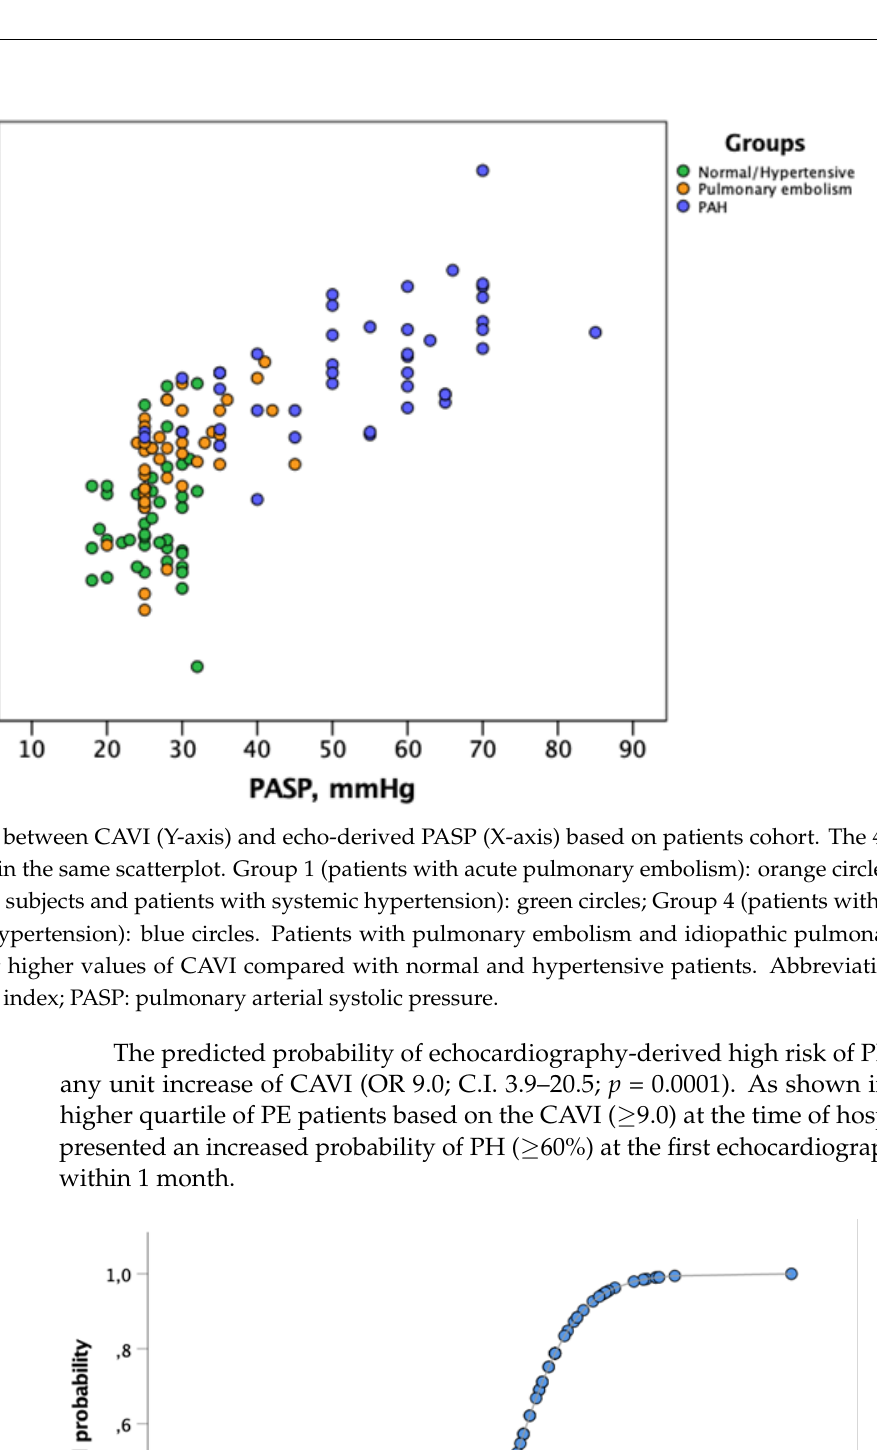
Table 2 Baseline demographic and clinical characteristics of patients with acute pulmonary embolism and CTEPH. Acute PE